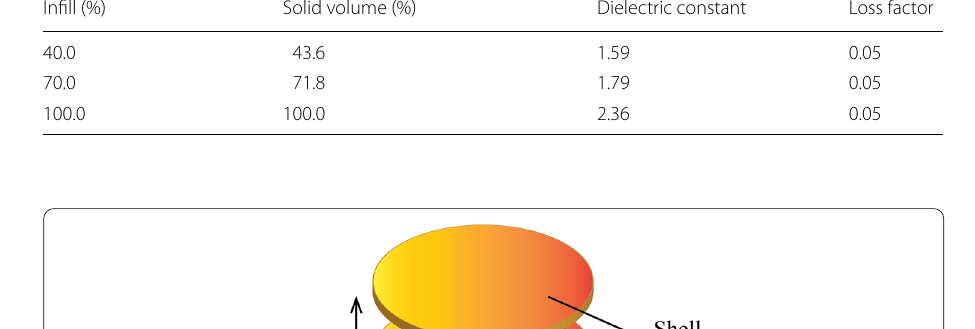
Table 1 Dielectric properties of 3D-printed TPU in three different infill levels Infill (%)